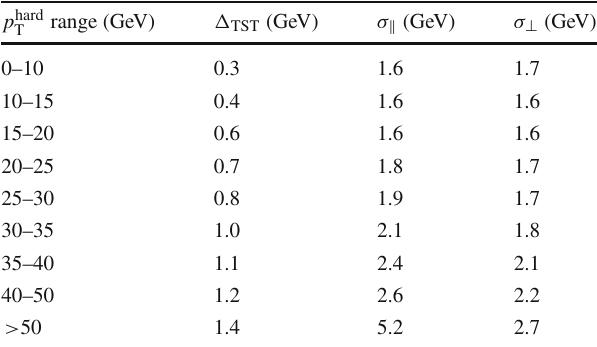
Table 6 The TST scale ( (cid:12) TST ) and resolution uncertainties ( σ (cid:10) and σ ⊥ ) are shown in bins of p hard T